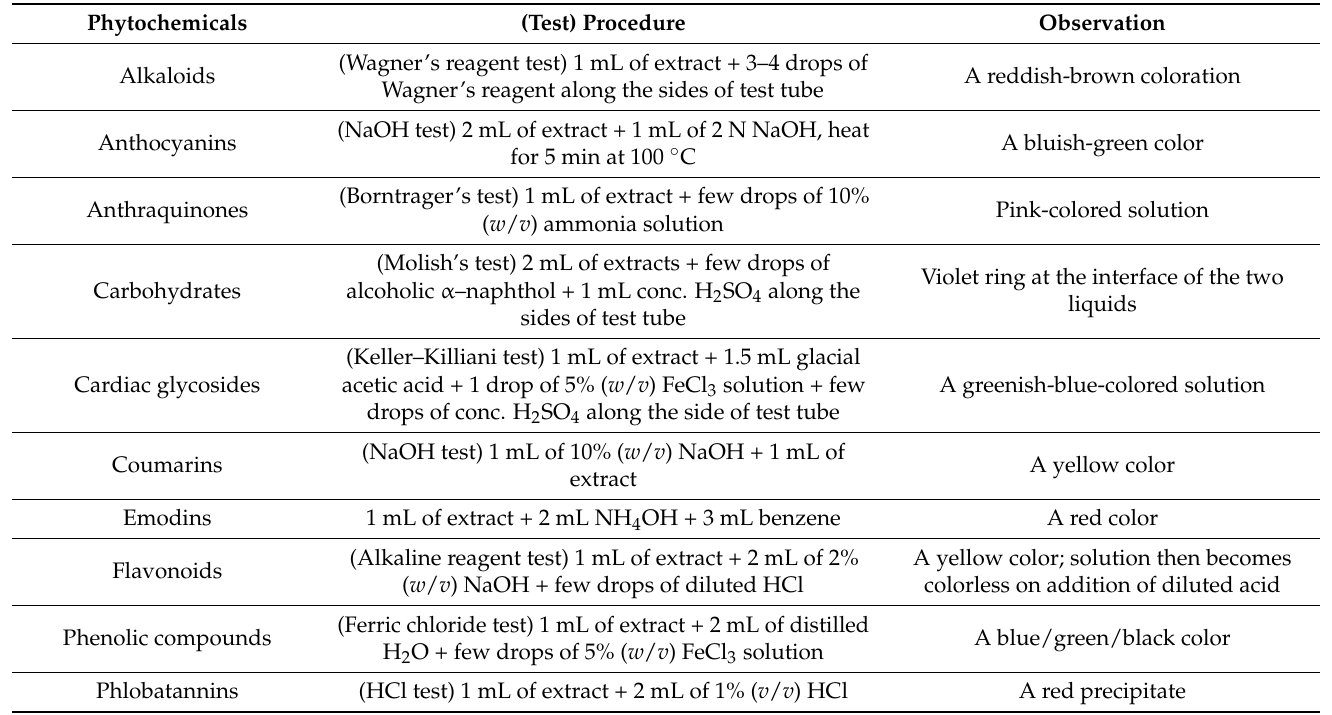
Table 6. Qualitative methods for phytochemical screening